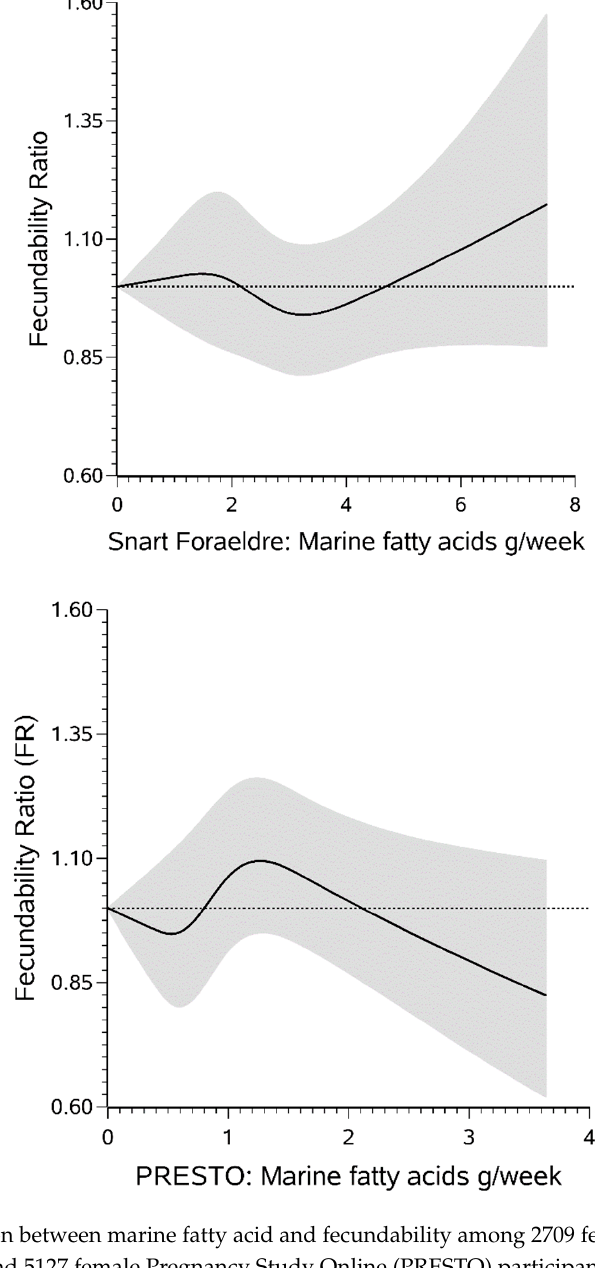
Figure 2. Association between marine fatty acid and fecundability among 2709 female Snart Foraeldre participants ( top ) and 5127 female Pregnancy Study Online (PRESTO) participants ( bottom ), fitted by restricted cubic splines. The reference level for the fecundability ratio is the lowest value in the data in each cohort. The splines are trimmed at the 99th percentile and have 4 knot points at the 25th, 50th, 75th and 90th percentiles. For Snart Foraeldre, knot points are at 1.00, 1.84, 2.90, and 4.30 and for PRESTO, knot points are at 0.36, 0.59, 1.00, and 1.64. Both splines are adjusted for age, BMI, physical activity, smoking status, alcohol intake, last form of contraception, intercourse frequency, parity, use of methods to improve pregnancy chances, daily multivitamin use, use of fish oil supplements, education, income, marital status, race / ethnicity (PRESTO only), healthy diet indices, and sugar-sweetened beverage intake.